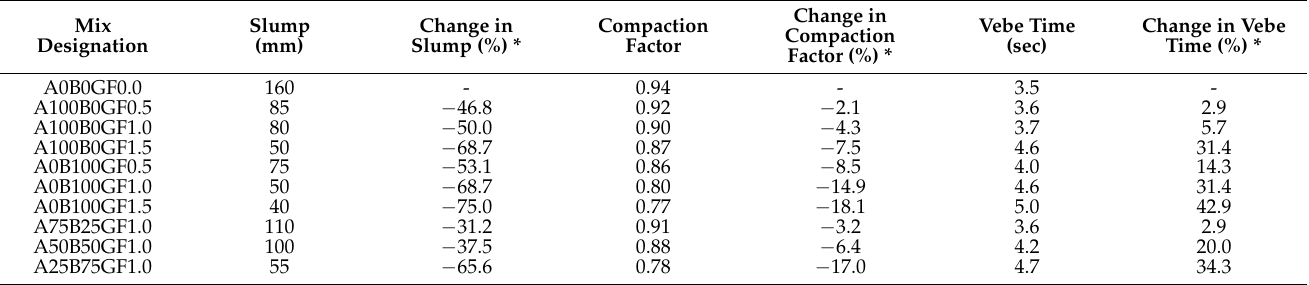
Table 5. Slump, compaction factor, and vebe time for geopolymer concrete